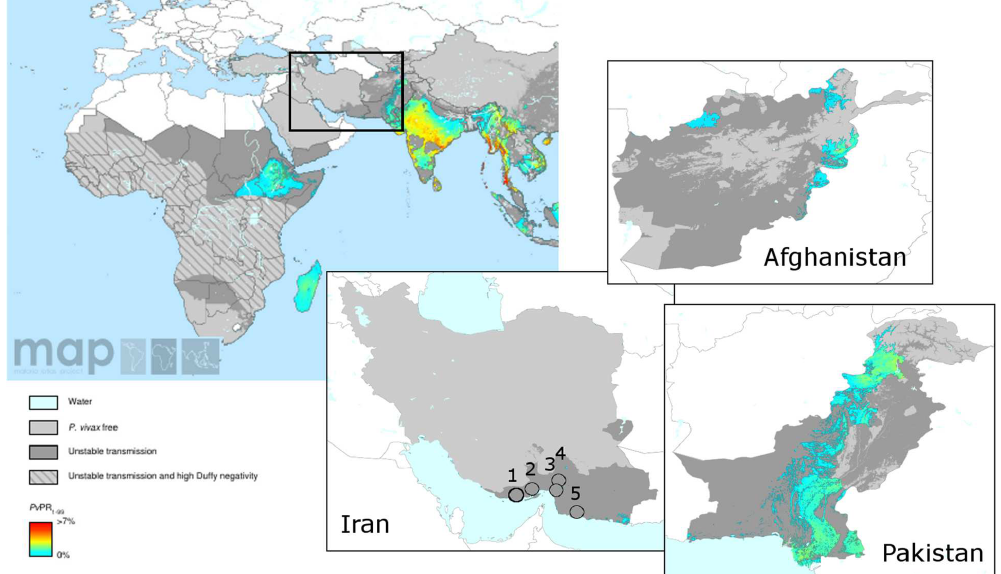
Fig 1. P . vivax prevalence maps. These maps were generated by the Malaria Atlas Project, Universityof Oxford. The colourscales reflect the model-based geostatistical point estimates of the annualmean P . vivax parasite rate in the 1–99 year age range ( Pv PR 1-99 ) [17] within the stable spatiallimits of transmissionin 2010. The approximate locationsof the study sites describedhere are indicatedwith numberedopen circles in the Iran panel:Bandar LengehCounty (1), Qeshm County (2), Minab County (3), RudanCounty (4) and Jask County (5). All MAP maps are availableto users under the CCAL 3.0.